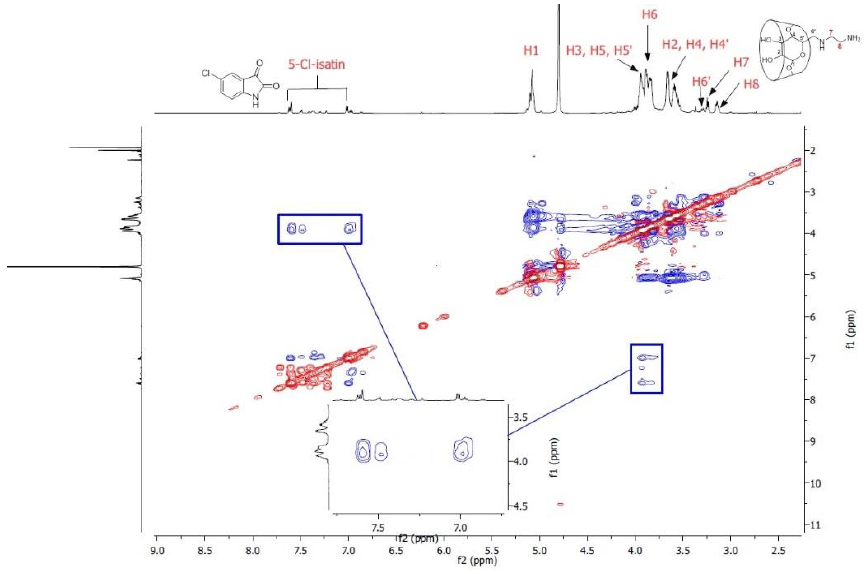
Figure 3. 2D ROESY NMR spectrum (600 MHz) of the AEA– β –CD complex with 5-chloroisatin (CI). The solution contained deuterium oxide (D, 99.9%), CI (10 mM), and AEA– β –CD (10 mM). Mixing time: 400 ms.